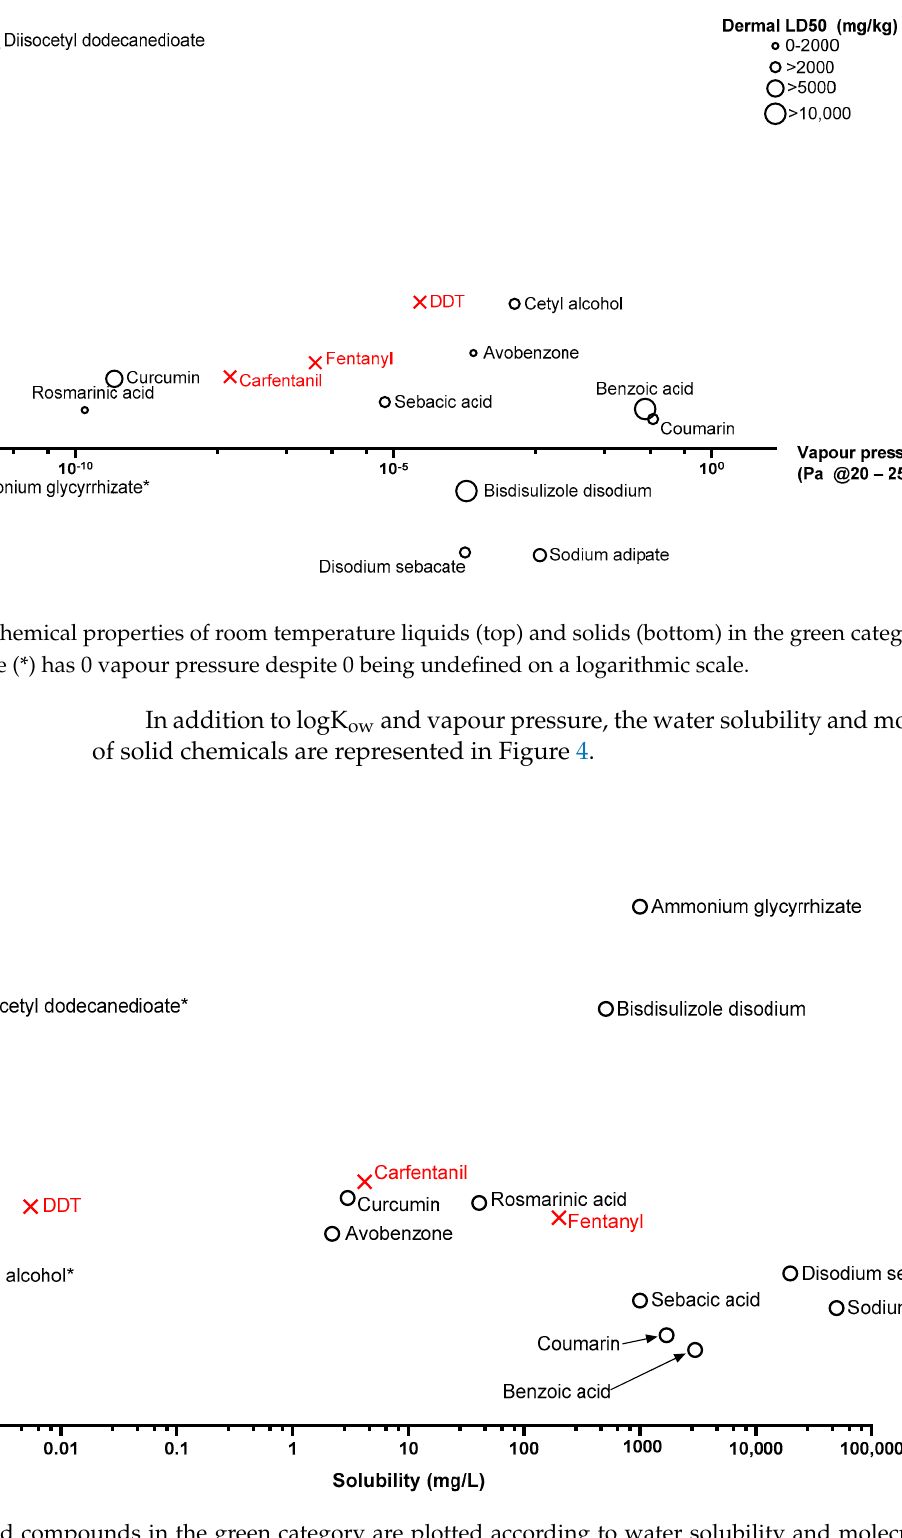
Figure 4. The solid compounds in the green category are plotted according to water solubility and molecular weight. (*) indicates 0 mg/L solubility despite 0 being undefined on a logarithmic scale.